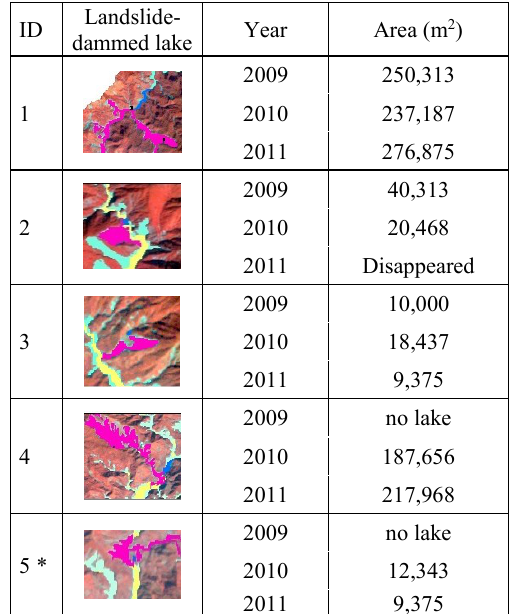
Table 3. Landslide-dammed lakes detected using semi- automated feature extraction. * The triggering landslide for this landslide-dammed lake was not detected on 2010 (false negative in Table 2), however, it was detected on the 2011 image.